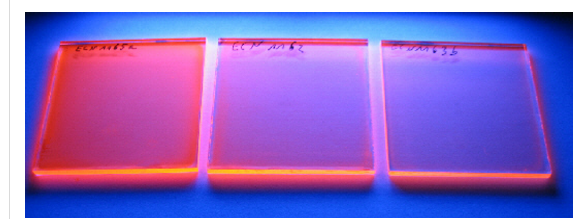
Figure 9: Photograph of CTA nanocomposite layers on glass substrates containing NRs (aspect ratio 6) illuminated with UV-radia- tion of 365 nm. The NR concentration is varied from left to right, i.e., 2 wt %, 1 wt %, and 0.5 wt %.